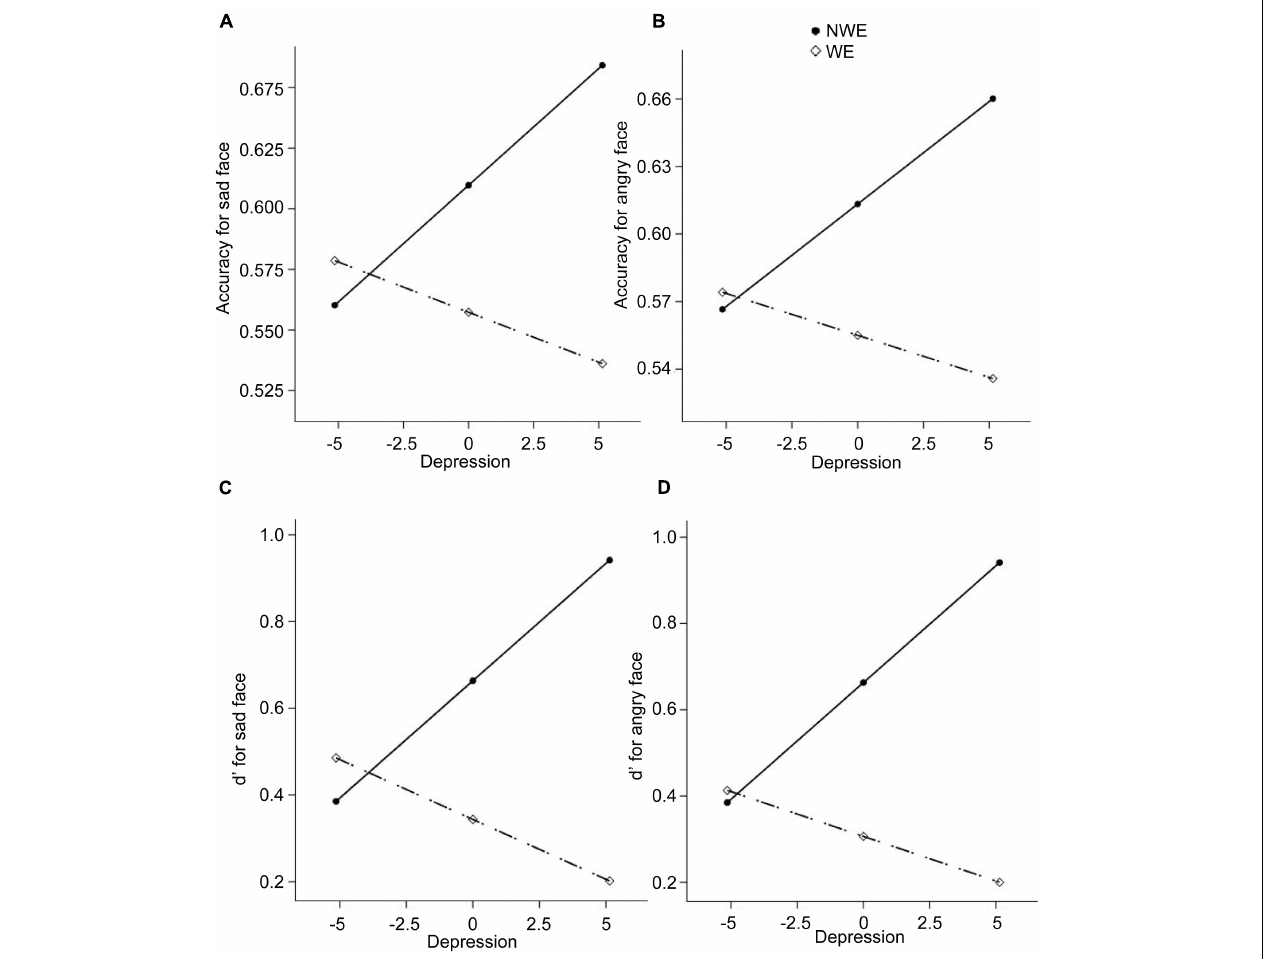
FIGURE 2 | The moderation effect of depression on the relationship between widowhood and the performance in the delayed-match-to-sample (DMTS) experiment. The dependent variables are the mnemonic accuracy for sad faces, the mnemonic accuracy for angry faces, d (cid:48) for sad faces, and d (cid:48) for angry faces, respectively, for (A–D) . NWE, non-widowed elderly; WE, widowed